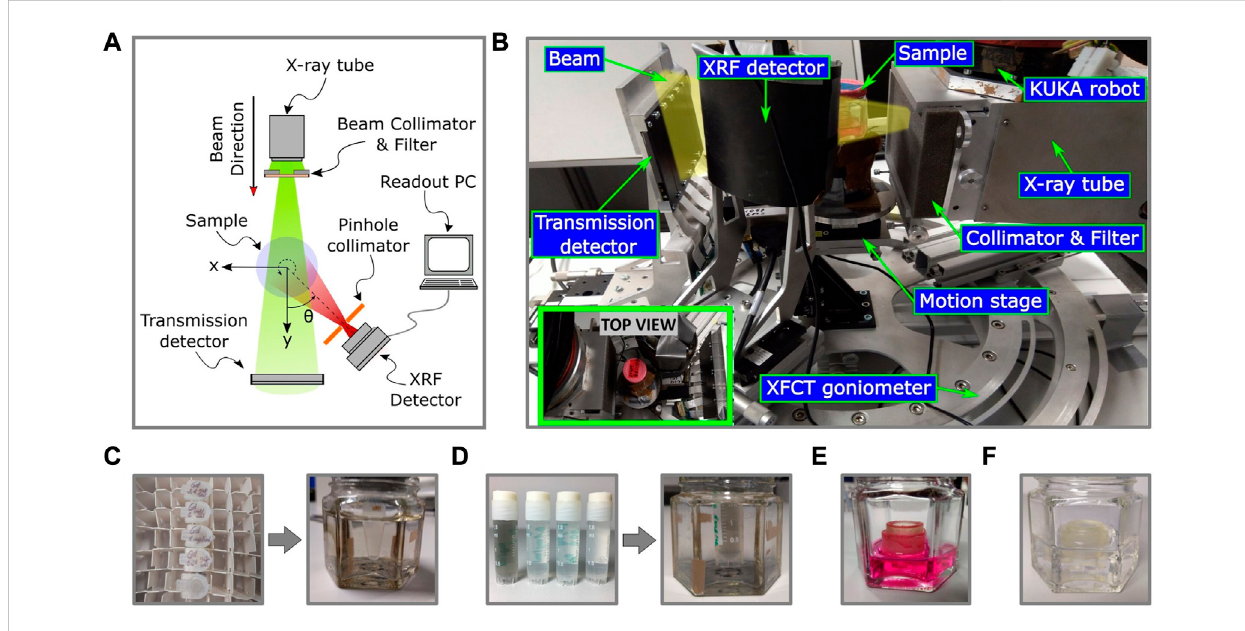
FIGURE 3 The schematic diagram (A) and the experimental setup (B) ofthe benchtop XFCT system is shown here, including theimaging phantoms (C) , (D) (E) , and (F) .Image (B) showcasestheimaginggeometryandthevariouscomponentsinvolved,includingamicrofocusX-ray tubewithacollimator andbeam fi lteringsystem,amotionandmountingplatform,atransmissiondetector,andashieldedXRFdetectorwithsinglepinholecollimation.Theinsetimagein (B) shows the top view of the setup. The Gd (C) and MoNP (D) calibration samples are embedded in water and held inside borosilicate glass containers. The Gd calibration samples (C) have concentrations ranging from 0 – 3.1 mg/mL, and the MoNP calibration samples are shown in (D) (only 0, 0.1, 0.25, and 0.5 mg/mL are shown here). The 3D breast cancer tissue model is immersed in cell growth medium (E) and blank cell crown samples are held in water for XRF background analysis (F)